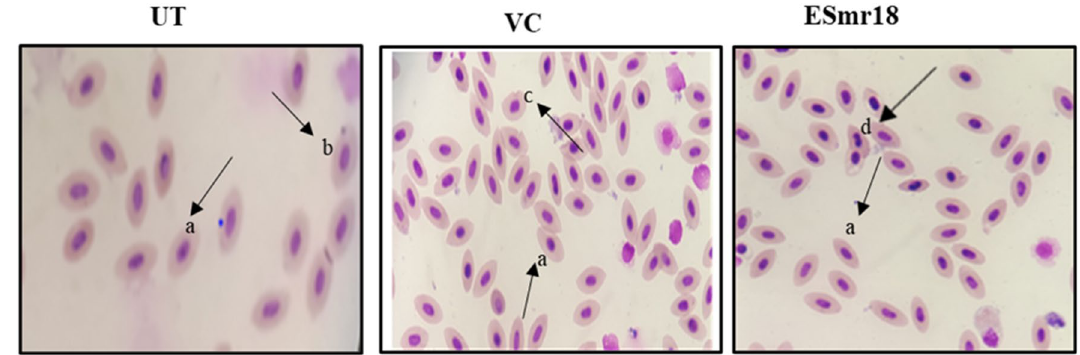
Fig. 8 Nucleo-cellular abnormalities in the blood cells of C. mrigala (a) normal cells (b) micronuclei (c) necrotic cell (d) lobed